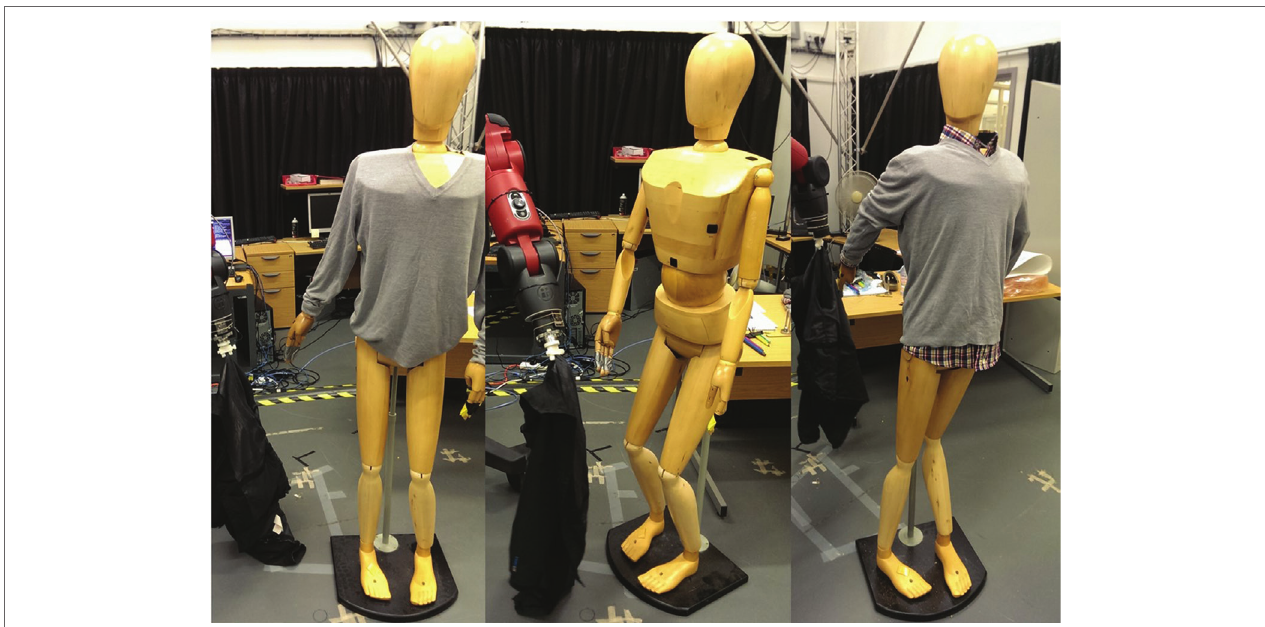
FigUre 3 | Mannequin poses used during this study (left to right): (pose 1) low mobility user with a straight arm at a slight angle to the side dressed with a jumper, (pose 2) limited mobility user with the arm out to the front for the bare mannequin, and (pose 3) normal mobility with the arm bent around the back and the elbow bent with all three layers (t-shirt, shirt, and jumper)